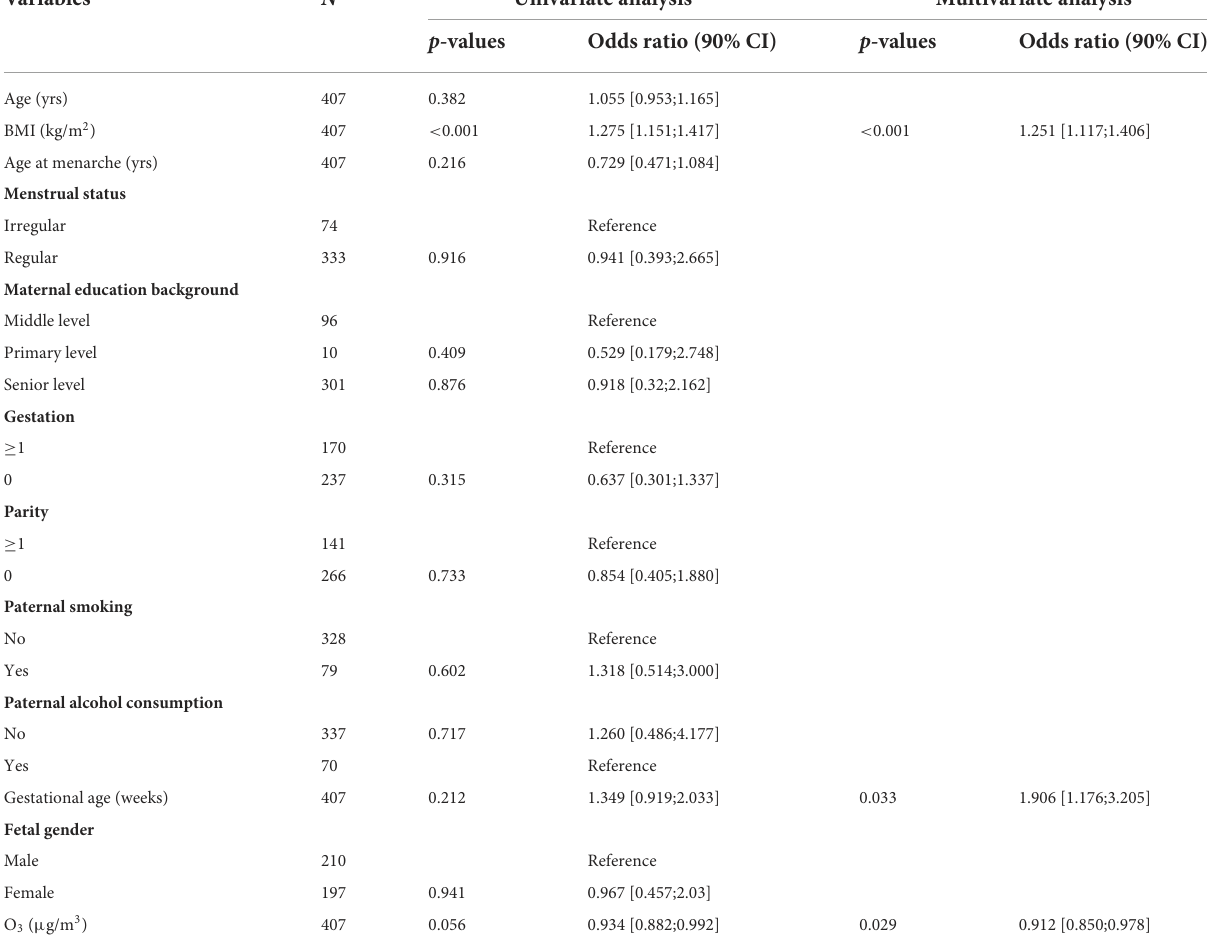
TABLE 2 Univariate and multivariate logistic regression analysis showing predictors of